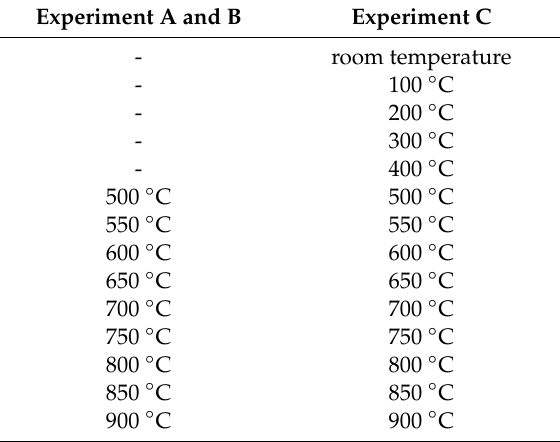
Table 1. Temperature Steps of Each